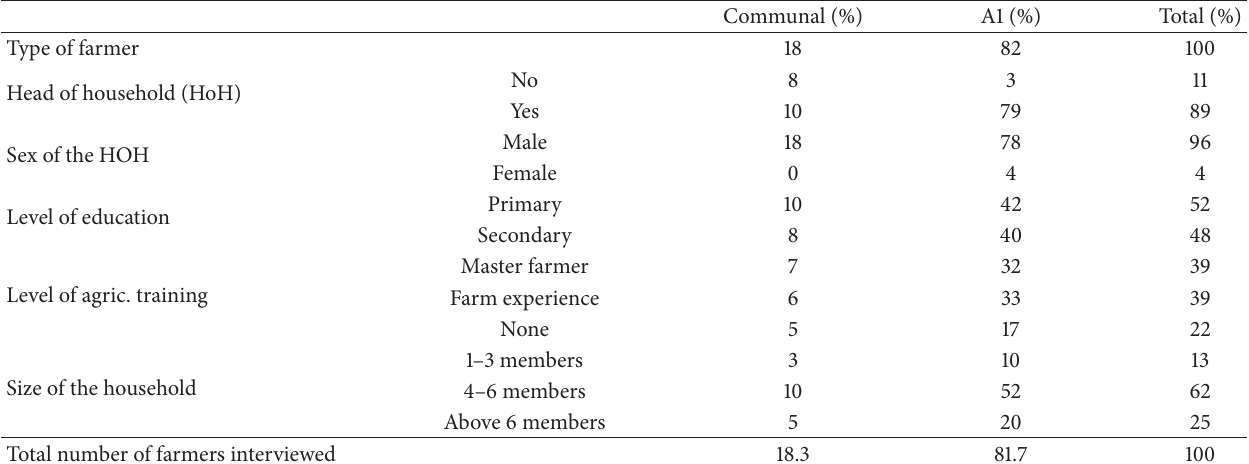
Table 1: Information of smallholder tobacco farmers interviewed.